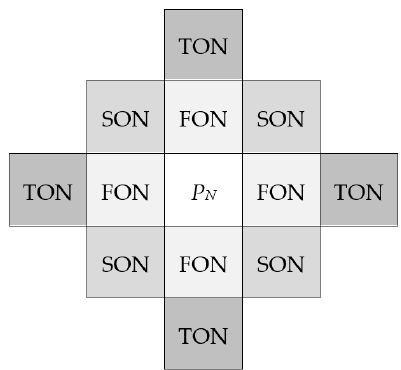
Figure 2. FON, SON and TON pixels positions.